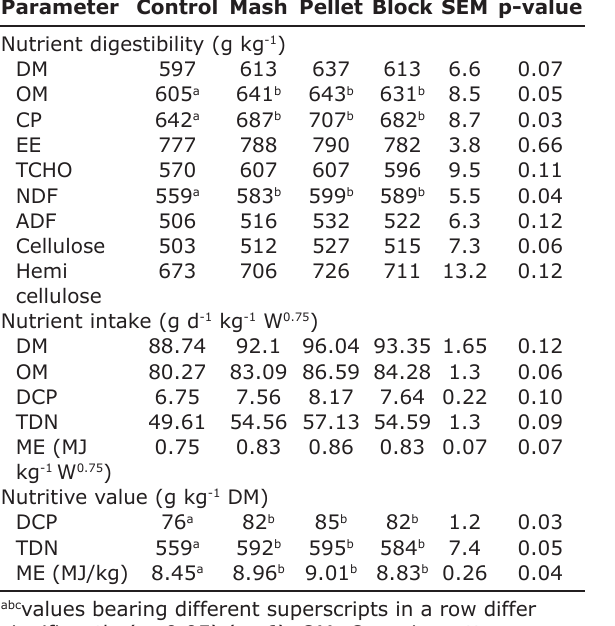
Table-2: Effect of differently processed sorghum stover-based complete rations on intake and nutrient digestibility in lambs.